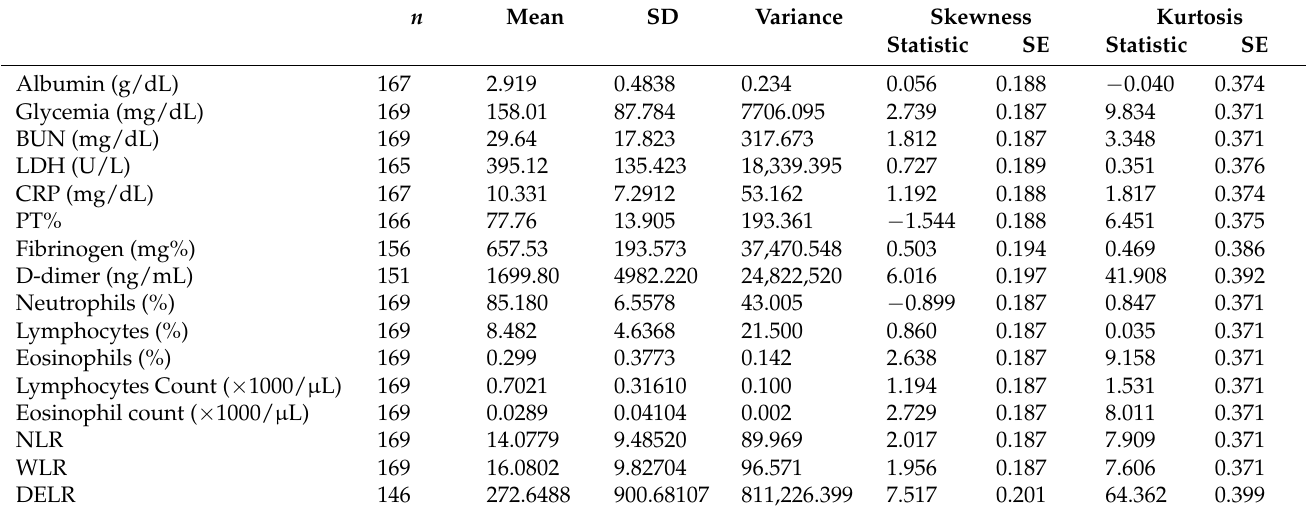
Table 4. Descriptive statistics of blood tests in the COVID-19 prospective cohort. WLR, white blood cell to lymphocyte count; DELR, d-dimer to (eosinophils% + lymphocytes%).